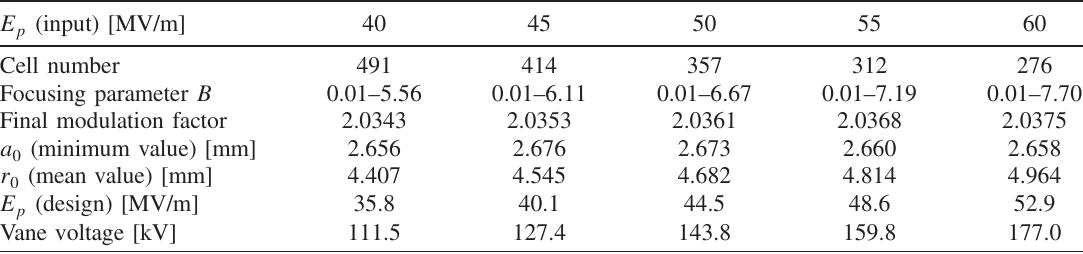
TABLE VII. Cell parameters designed using RFQGen software with SC-RFQ for 5 MeV proton beam